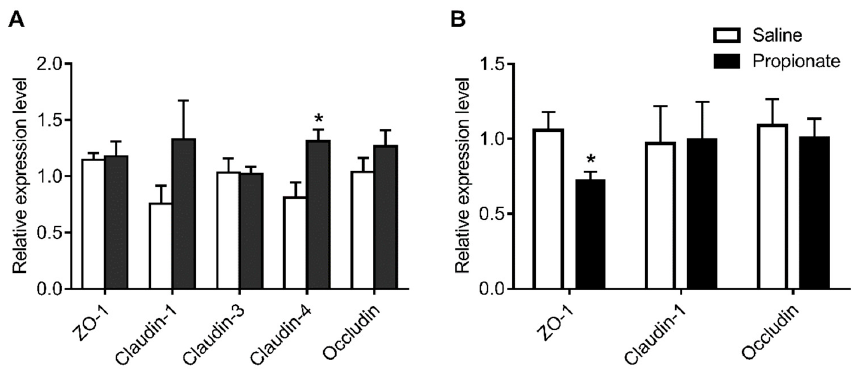
Figure 2. Effect of the cecal infusion of propionate on the mRNA levels of tight junction proteins in the jejunum ( A ) and colon ( B ).